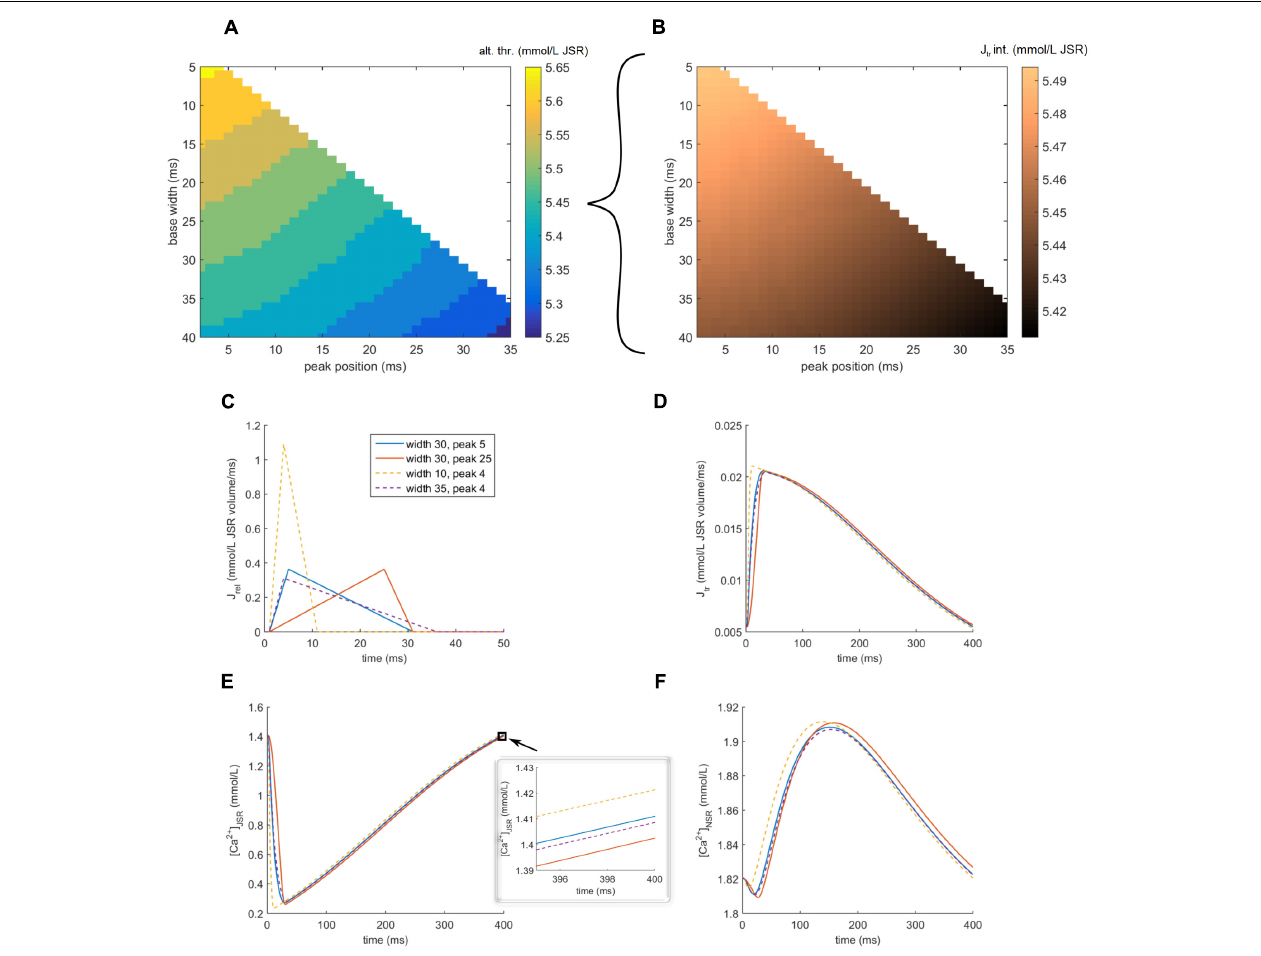
FIGURE 7 | Exploring shapes of SR release and alternans vulnerability in the HeRd model. (A) Shown here is the alternans threshold coded by color for various parameters of release triangle. Base width = release duration. Peak time = absolute time after stimulus administration corresponding to time to peak release. Alternans threshold = the level of total calcium released above which a cell with the given release duration and time to peak release fails to refill the JSR to the pre-release state within 400 ms (corresponding to one action potential at the prepacing bcl). (B) The integral of J tr (JSR refilling) for a fixed total released calcium of 5.45. (C) Shapes of four triangular releases with total released calcium 5.45. The dashed lines vary in release duration, while the solid lines vary in peak position, but have the same duration. (D) JSR refilling rate. (E) JSR free calcium concentration and an inset of last 5 ms, showing the final calcium concentrations. (F) NSR calcium